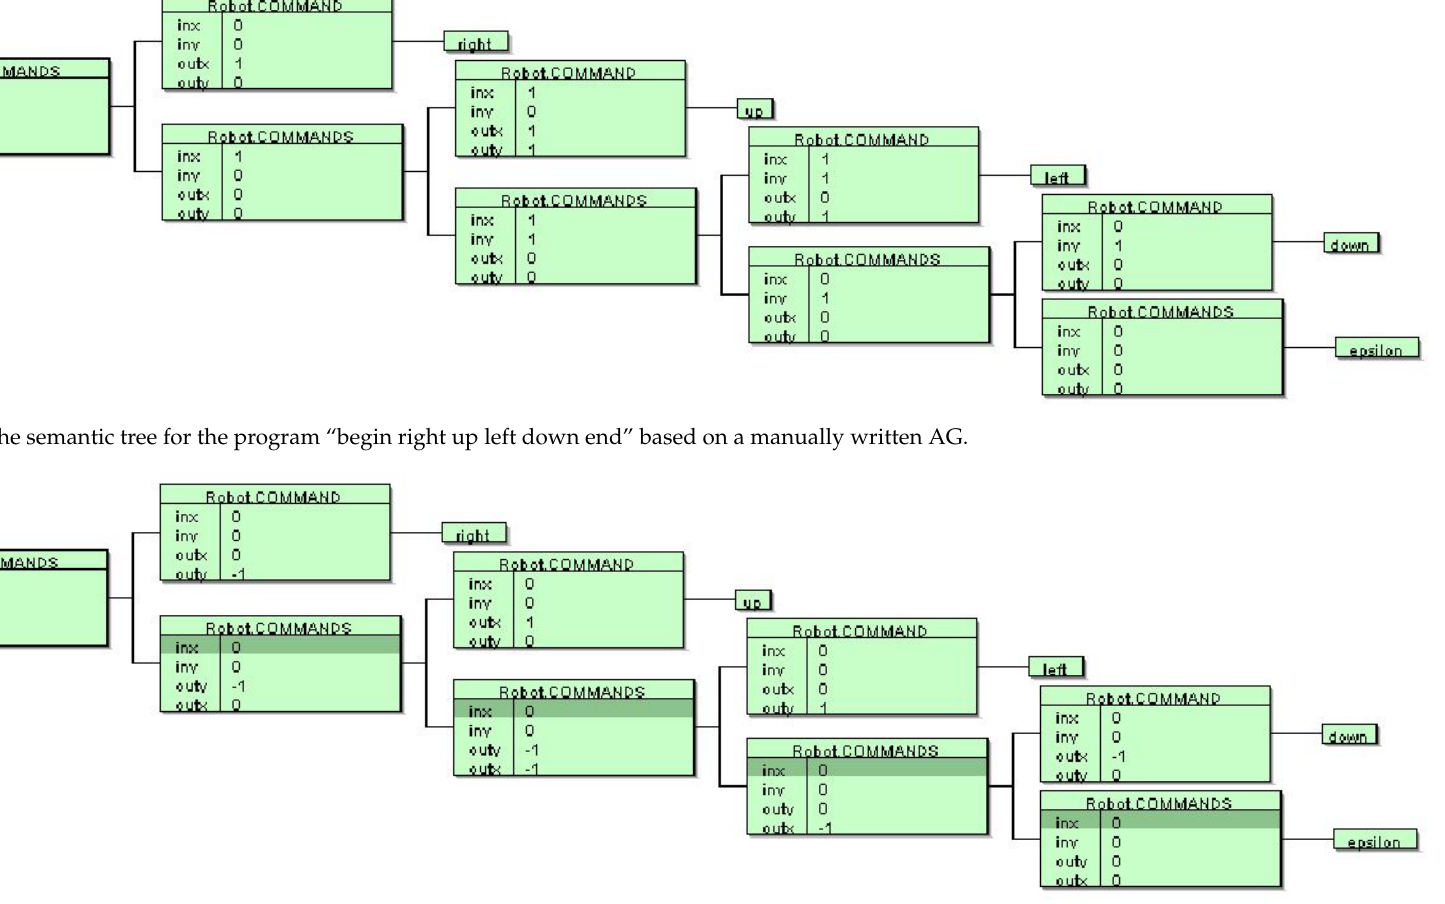
Figure 3. The semantic tree for the program “begin right up left down end” based on an automatically generated